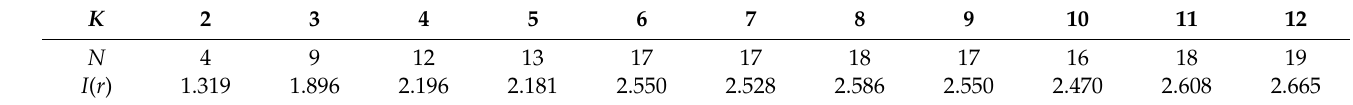
Table 2. The determining dates of grid dimension of the Fuzhou park system.